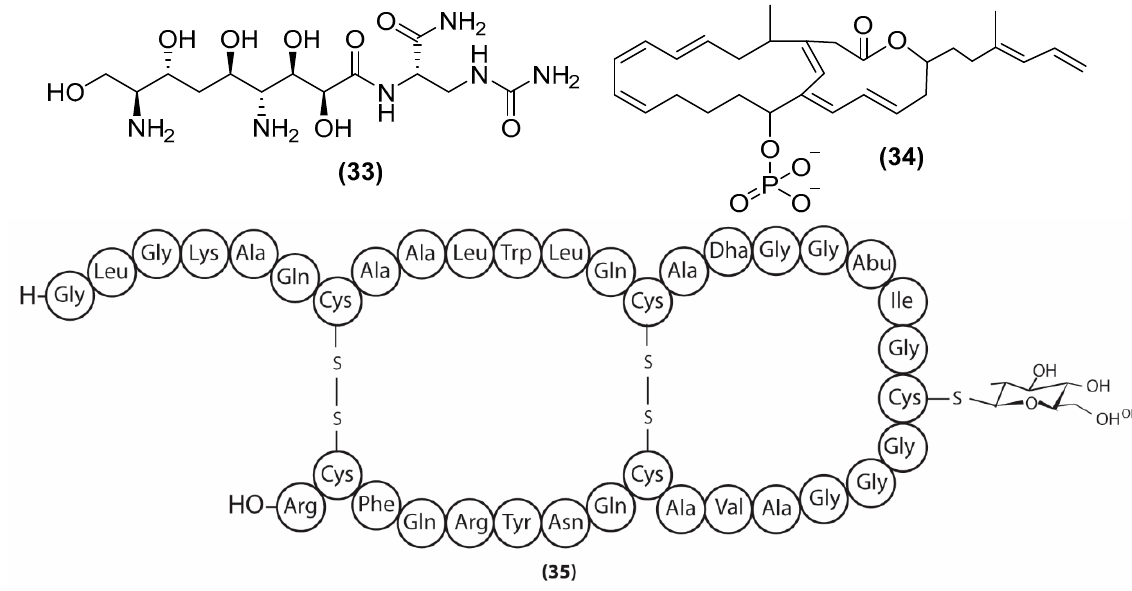
Figure 9. Chemical structures of zwittermicin A ( 33 ), difficidin ( 34 ), and sublancin ( 35 ).